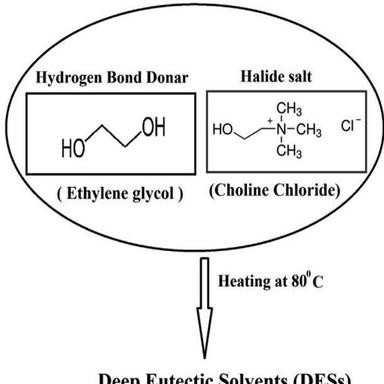
Structures of ethylene glycol and choline chloride used in synthesis of deep eutectic solvent.